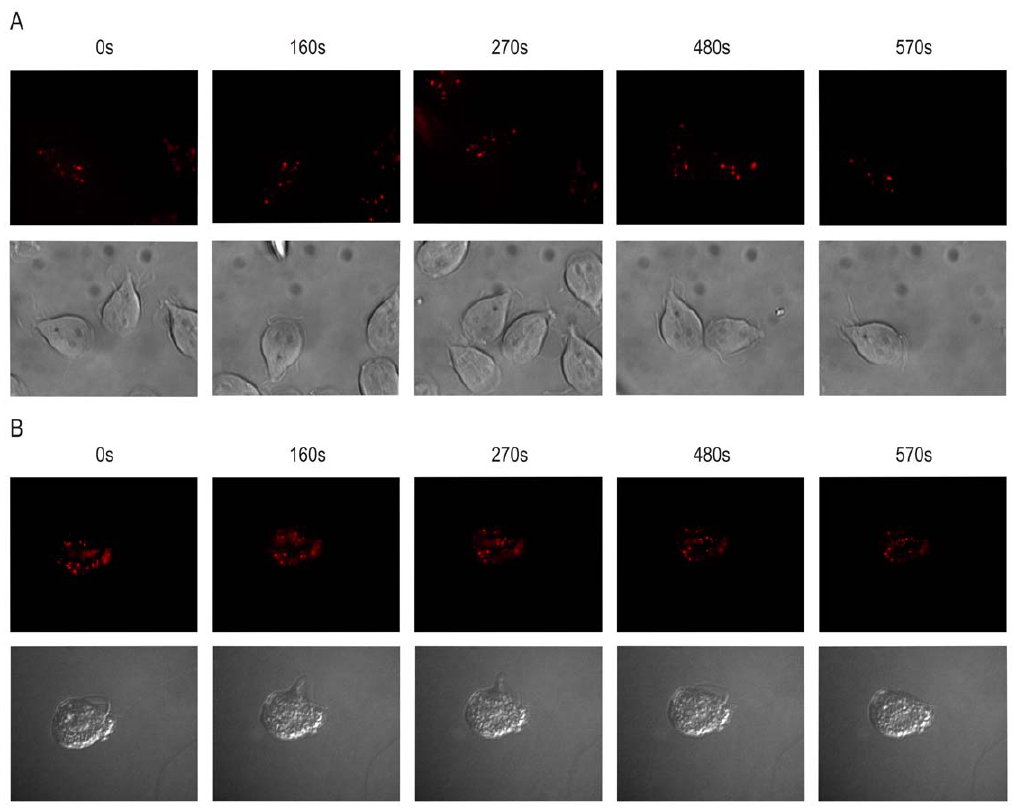
Figure 3. Live imaging of mitosomes and hydrogenosomes. Halo-TMR labeled organelles were followed in living cells. A) Labeled G. intestinalis cells were allowed to attach to the bottom of the well and directly observed while B) the labeled T. vaginalis cells were mounted in 2% agarose and then submitted to microscopy. Five different snapshots in time are shown. The original movies are part of the supplementary data.